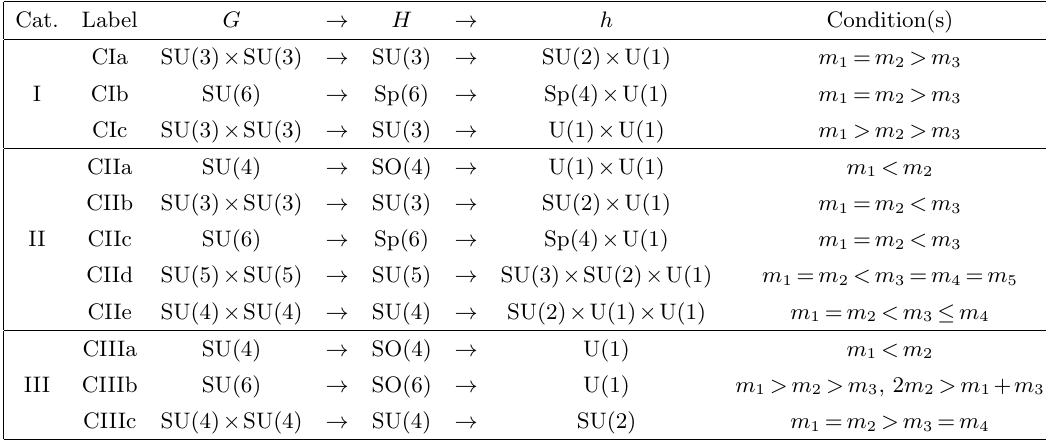
Table 1. Benchmark scenarios for the two categories of pion structures. The condition represents a relation that is assumed between the dark quark masses. It is sometimes crucial for the structure to be in a given category but not always. See appendix B for more